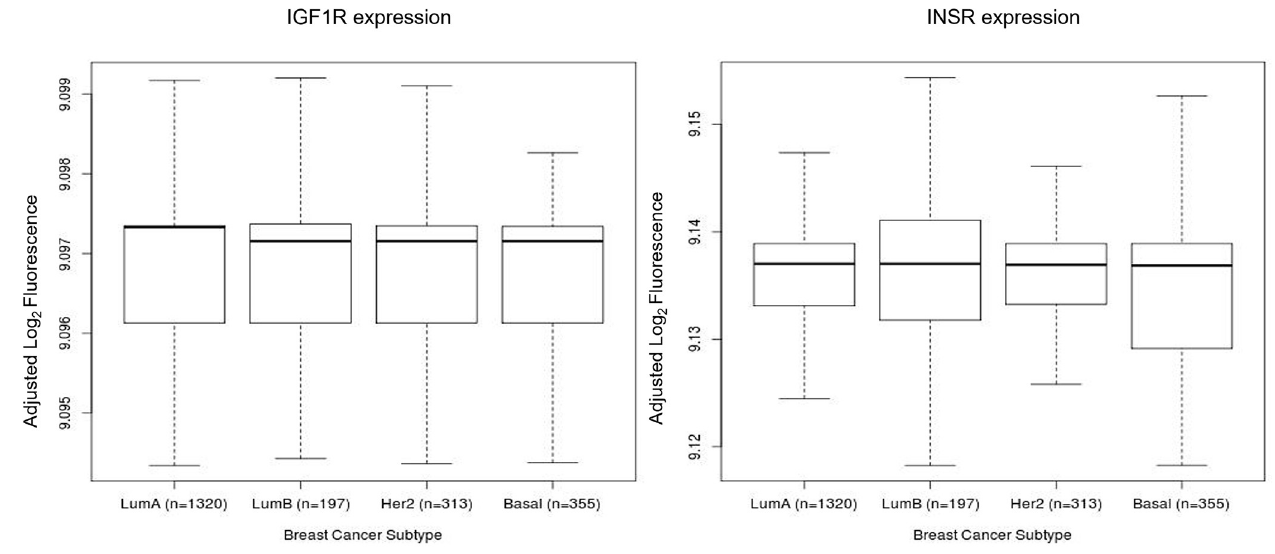
Fig 1. Expression of IGF1R and IR mRNA across the different breast cancer subtypes in the BreastMark database using the ssp2006 classifier. https://doi.org/10.1371/journal.pone.0282512.g001 lines. Linsitinib inhibited growth in 4 of the 11 cell lines tested. An IC value was achieved in 50 3/7 basal like cell lines, whilst an IC value was only reached in 1/4 non-basal-like cell lines, at 50 concentrations up to 10 μ M (Table 2). In 3D-cultures, linsitinib showed similar efficacy to that